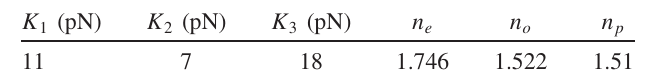
TABLE I. Values of the material constants used in the simu- lations. The values of the Frank constants K 1 indices n are experimentally measured for E7 at ambient e;o temperature [62,63]. The value of the refractive index n experimentally measured for typical crown glasses